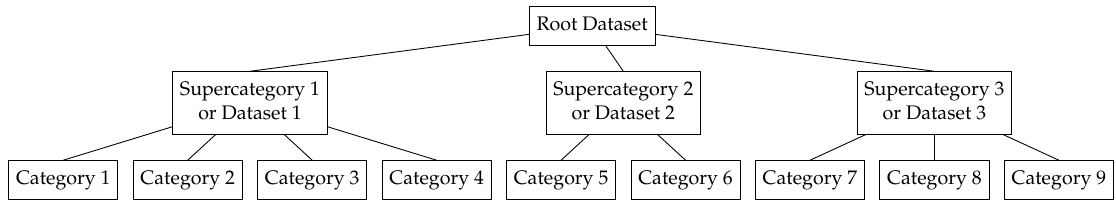
Figure 3. Example of a hierarchical dataset to be used by our cascade